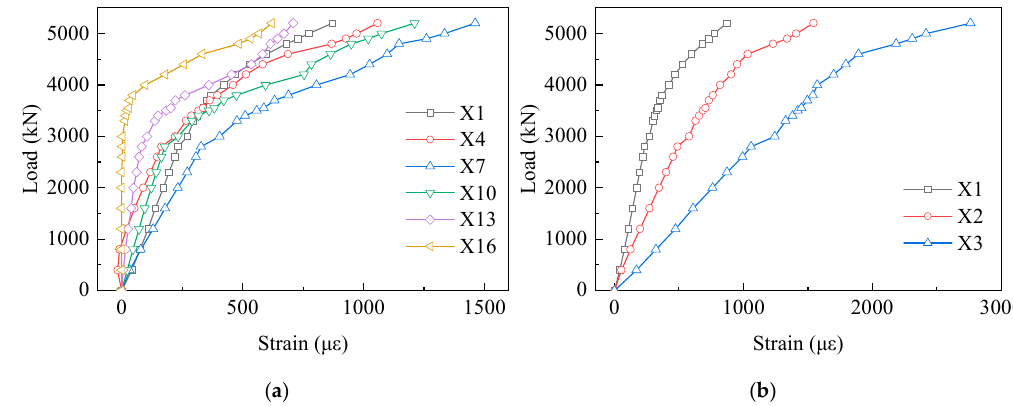
Figure 13. Load–strain curves of the perfobond rib (PBL) shear connectors: ( a ) X1 to X16 in the first row; and ( b ) X1 to X3 in the first column.